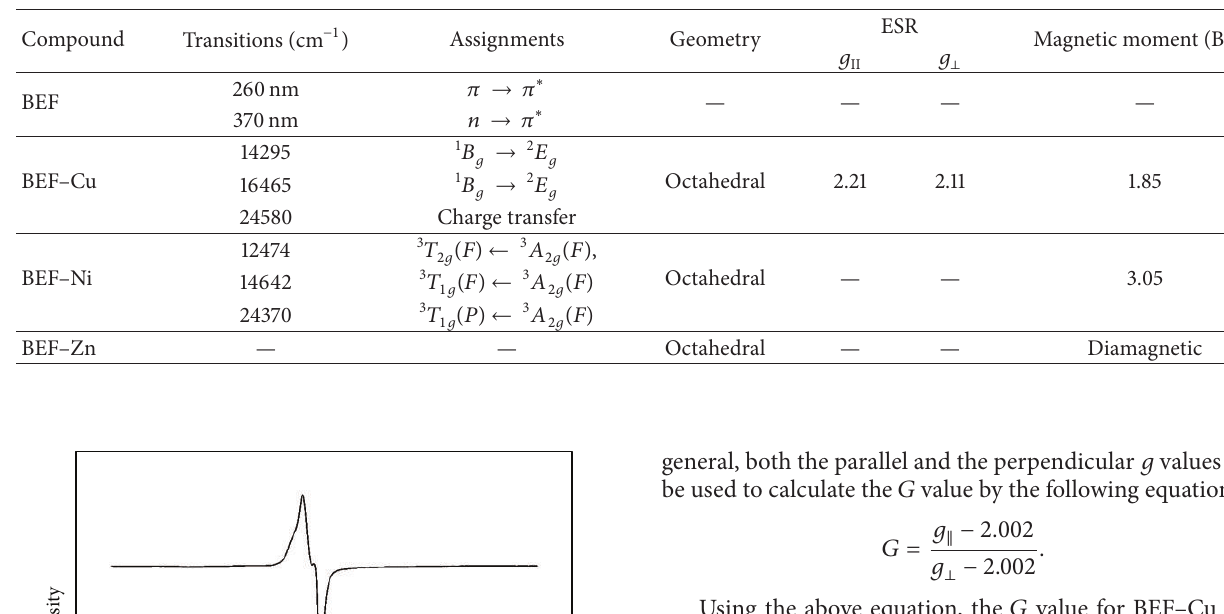
Table 3: UV-Visible, ESR data, and magnetic moments.